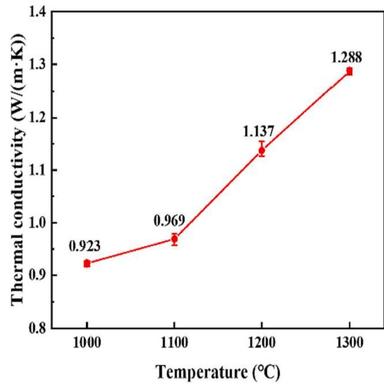
Thermal conductivity of samples with different sintering temperatures.